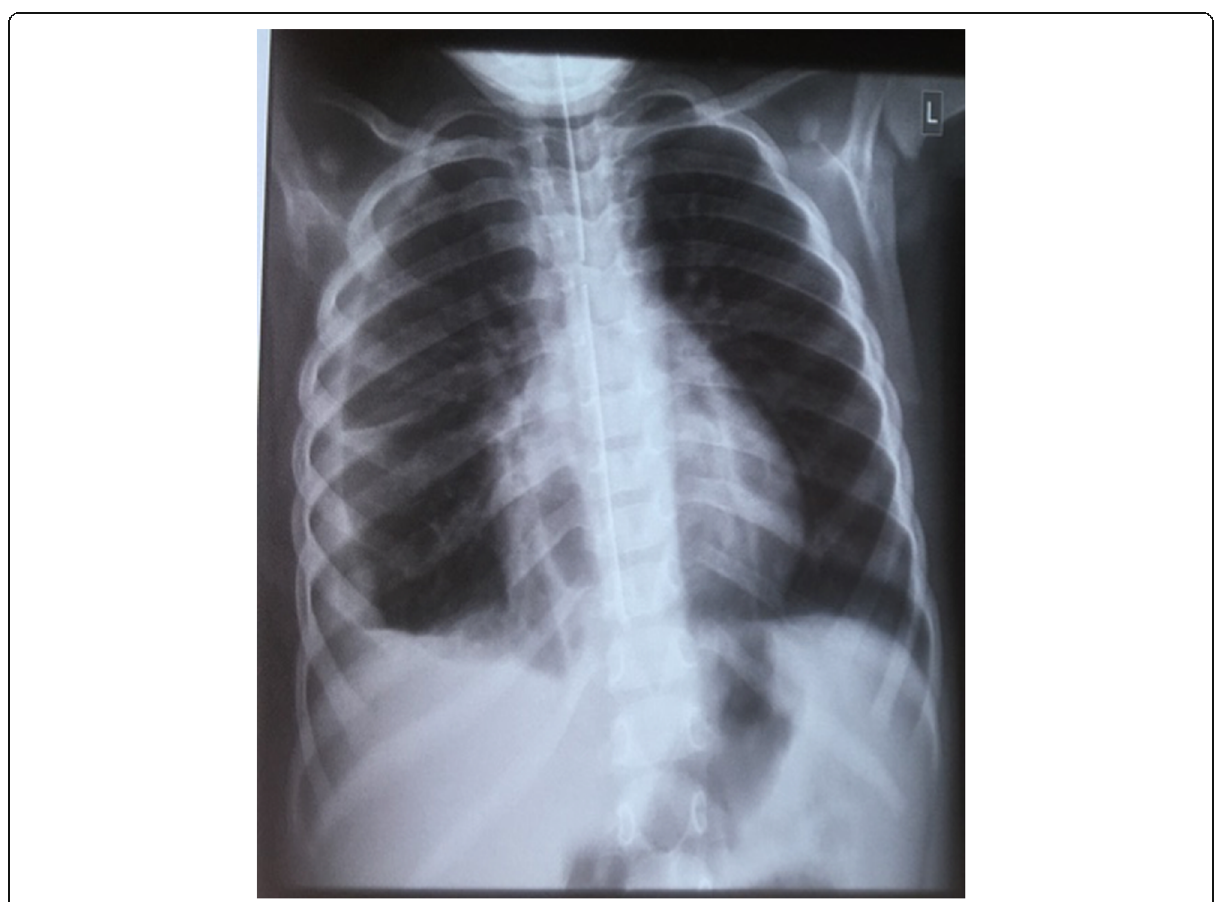
Fig. 4 Chest X-ray showing the total re-expansion of the right-sided lung and severe fibrosing pleuritis